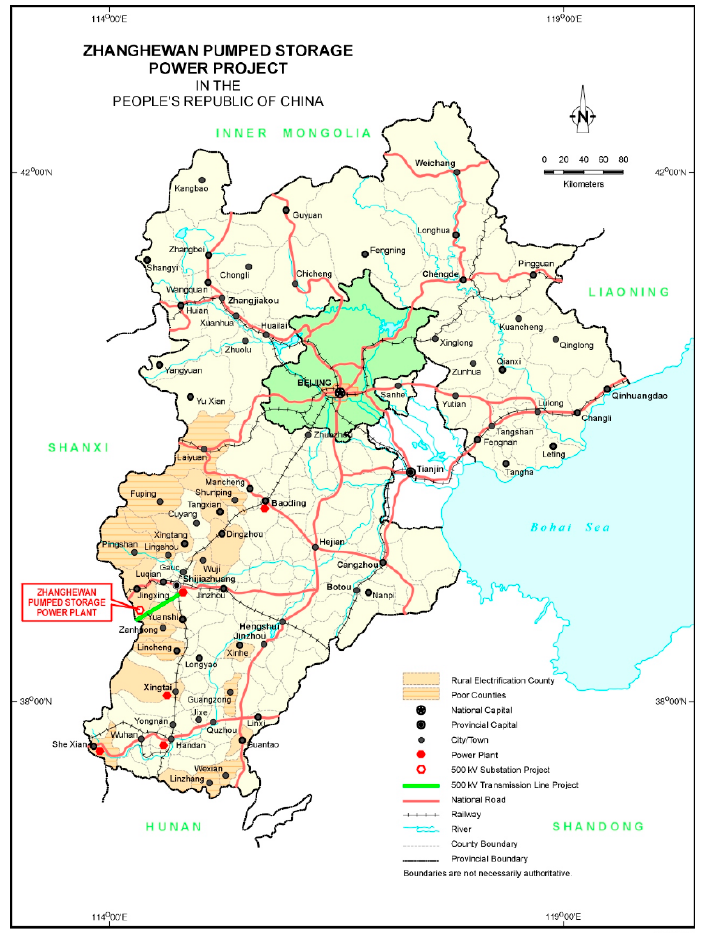
Figure 1. Project map. The main components and the installation area of the Zhanghewan PHS Project [57].